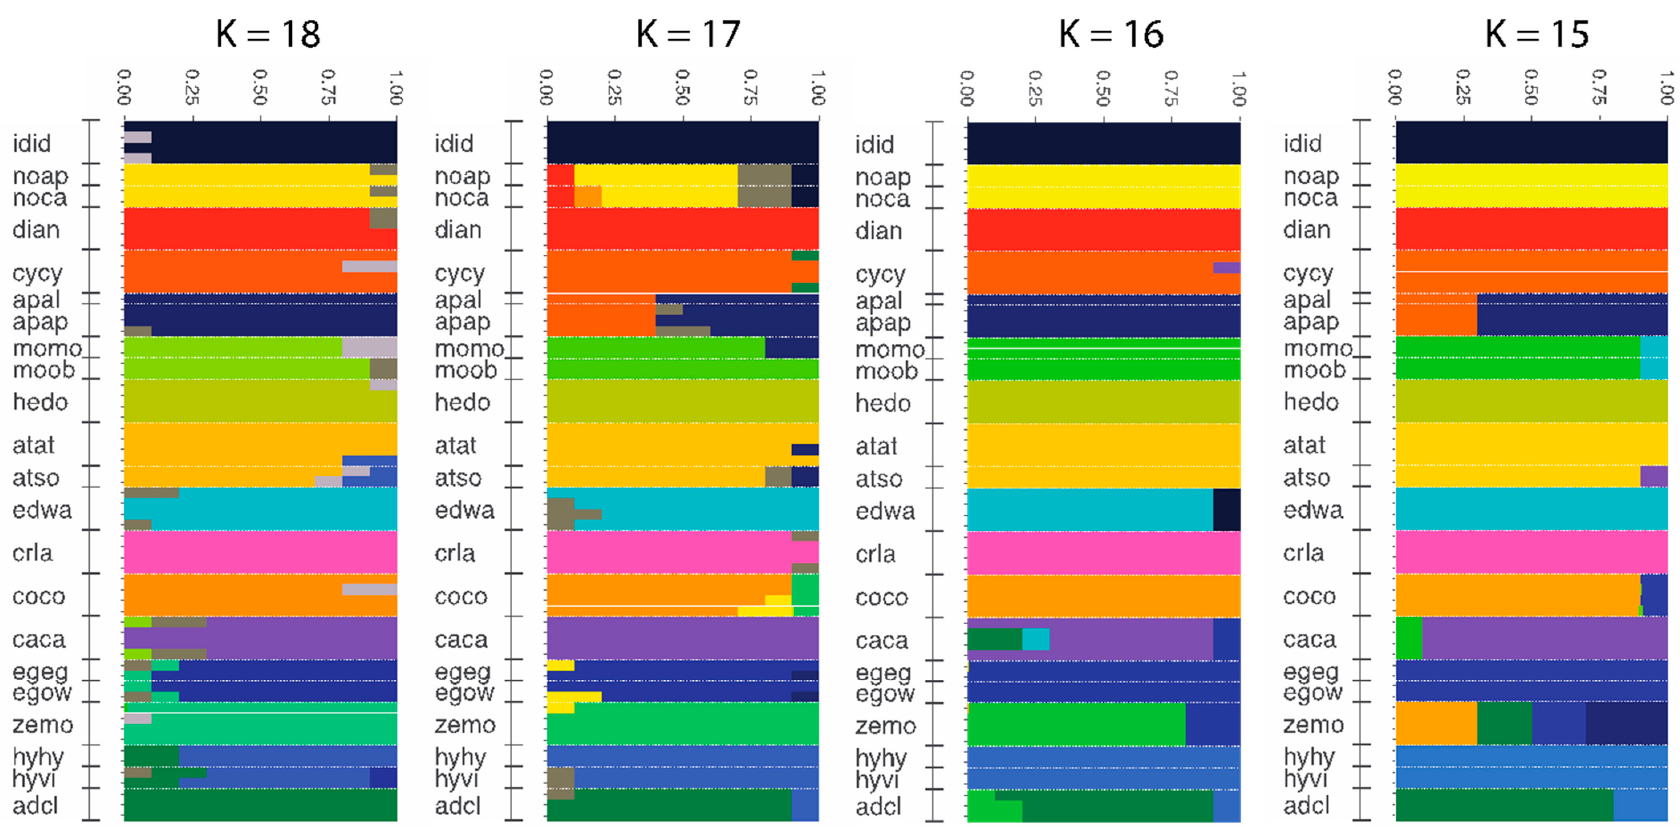
Figure 3. Admixture analysis results for Ks which recover the reproductively isolated species S. idalia and S. diana as distinct clusters. The four-letter codes indicting Speyeria species and subspecies are: idid = idalia idalia , noap = nokomis apacheana , noca = nokomis carsonensis , dian = diana , cycy = cybele cybele , apal = aphrodite alcestis , apap = aphrodite aphrodite , momo = mormonia mormonia , moob = mormonia obsidiana , hedo = hesperis dodgei , atat = atlantis atlantis , atso = atlantis sorocko , edwa = edwardsii , crla = carolae , coco = coronis coronis , caca = callippe callippe , egeg = egleis egleis , egow = egleis oweni , zemo = zerene monticola , hyhy = hydaspe hydaspe , hyvi = hydaspe viridicornis , adcl = adiaste clemencei .